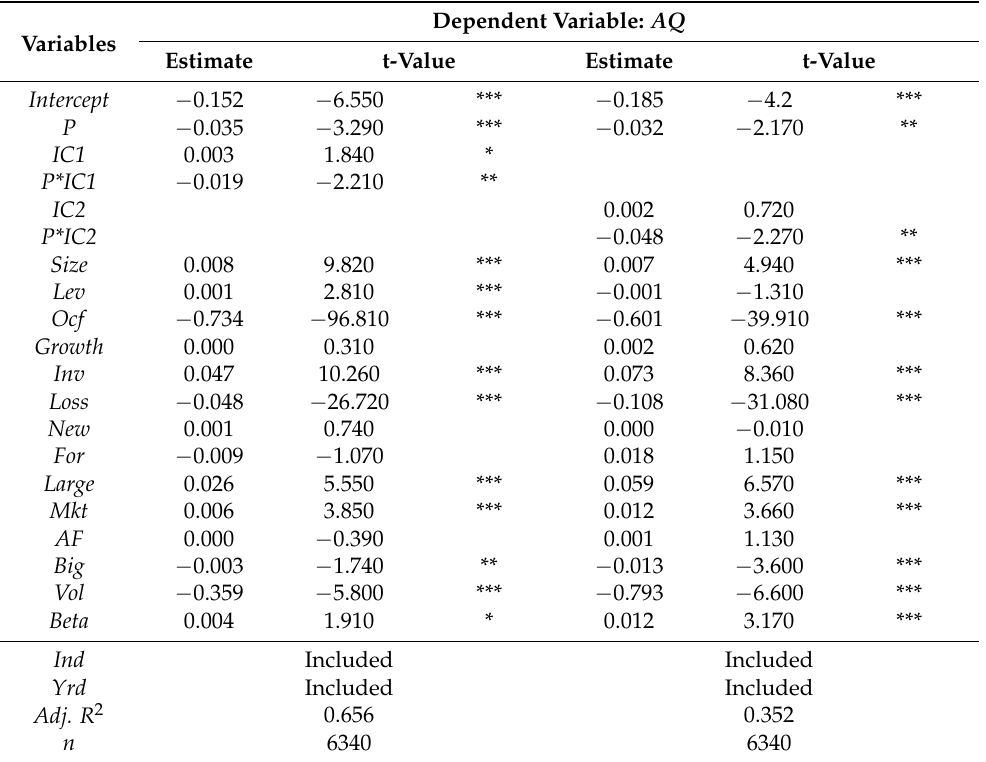
Table 7. Relationship between partner’s audit hour ratio and audit quality depending on internal control system. Number of internal control personnel in accounting and IT departments.